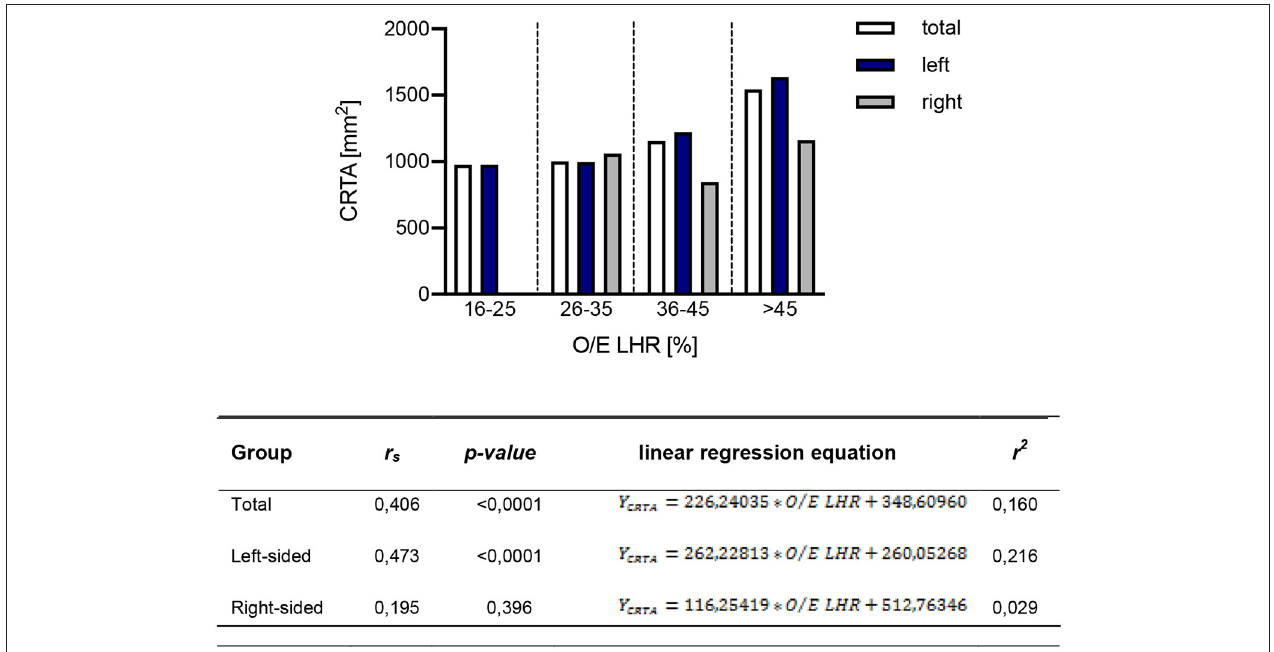
FIGURE 2 | Correlation of observed-to-expected lung-to-head ratio with CRTA. The correlation of observed-to-expected lung-to-head ratio and CRTA is shown in the total study population [ r s (168) = 0.406, p < 0.0001], in the group of left-sided [ r s (147) = 0.473, p < 0.0001] and right-sided CDH [ r s (21) = 0.195, p = 0.396]. CRTA, chest radiographic thoracic area; LHR, lung-to-head ratio; O/E, observed-to-expected; r s , correlation coefficient; r 2 , determination